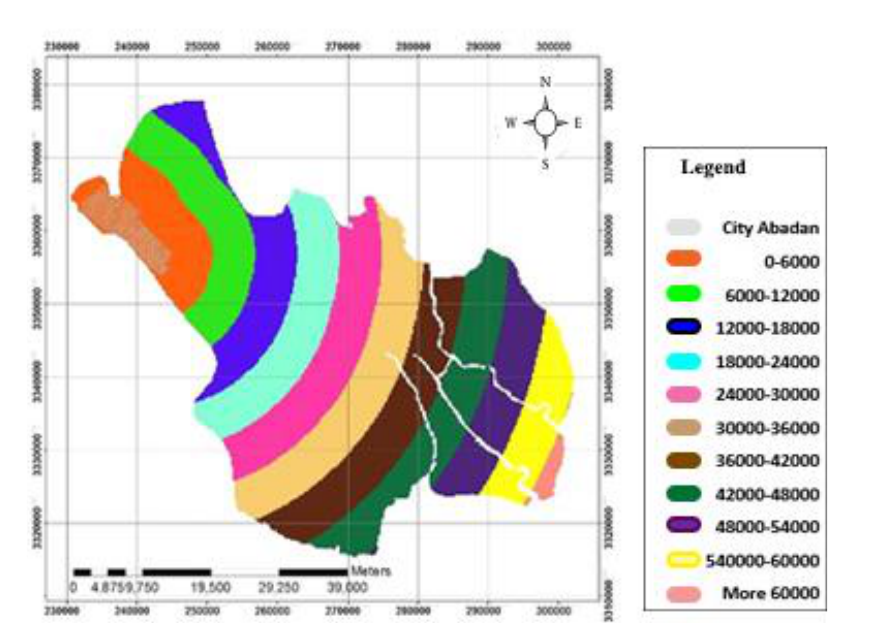
Fig. 6: Distance from urban